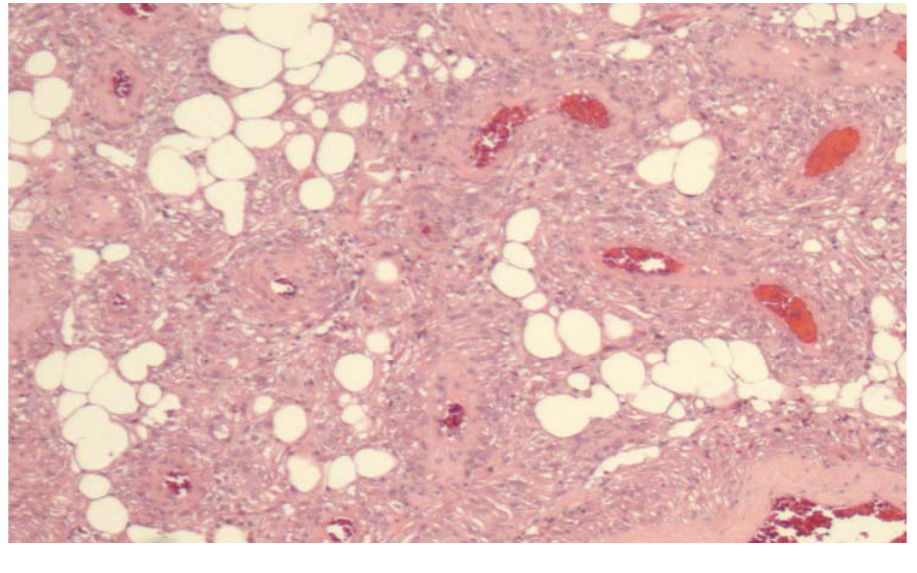
FIGURE 3. Angiomyolipoma